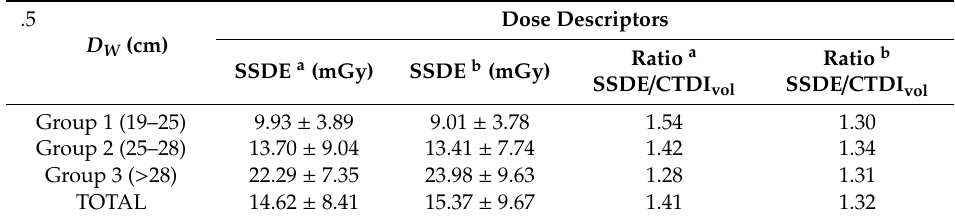
Table 3. A comparison of SSDE values obtained from AAPM and CT-Expo with their ratios to CTDI vol. .5